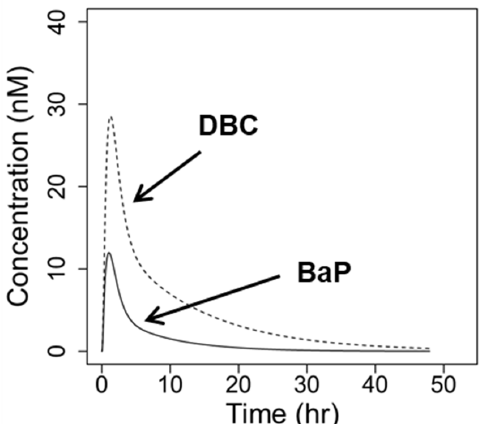
Figure 5. Predicted concentrations of benzo[a]pyrene (BaP, solid line) and dibenzo[def,p]chrysene (DBC, dashed line) in blood over time of a reference 73 kg human following an oral doses of 1 pmol BaP (0.25 ng) or DBC (0.30 ng), respectively.